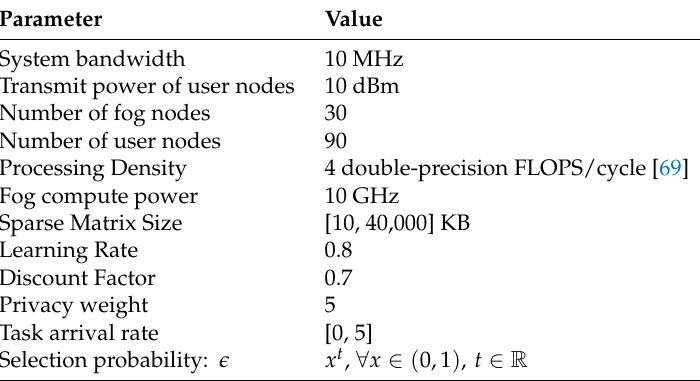
Table 1. UbiPriSec: Experimental Network